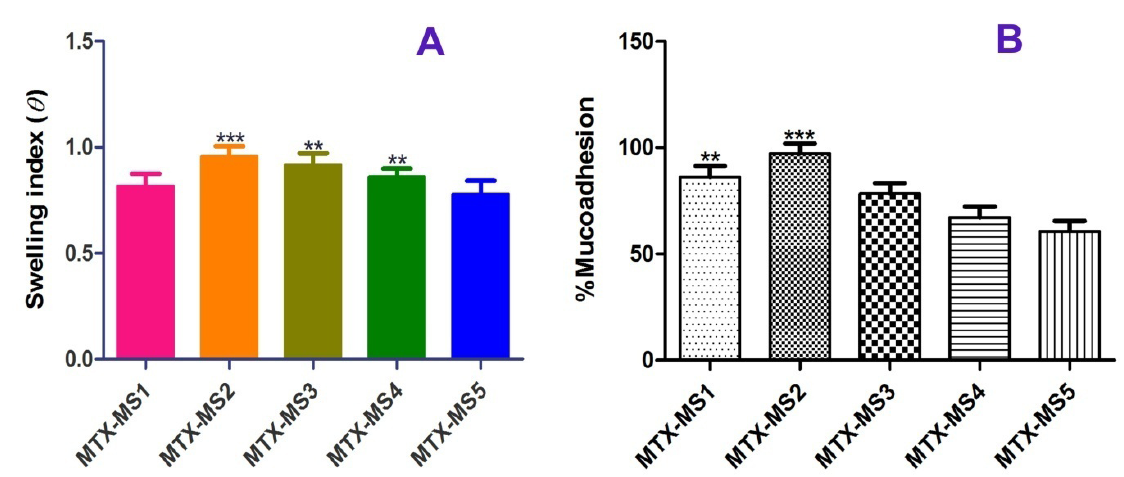
FIGURE 2 – Swelling index (A) and mucoadhesion (B) of different formulations, MTX-MS1-5. Values were mean ± SD (n = 3). ** P ˂ 0.05, *** P ˂